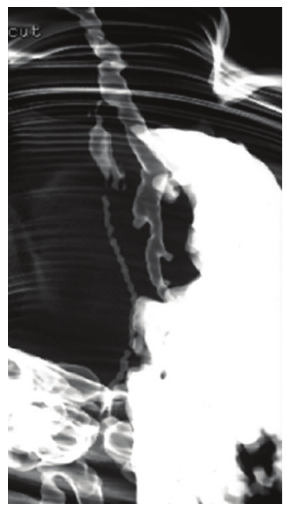
Figure 4: Left bronchus arising from